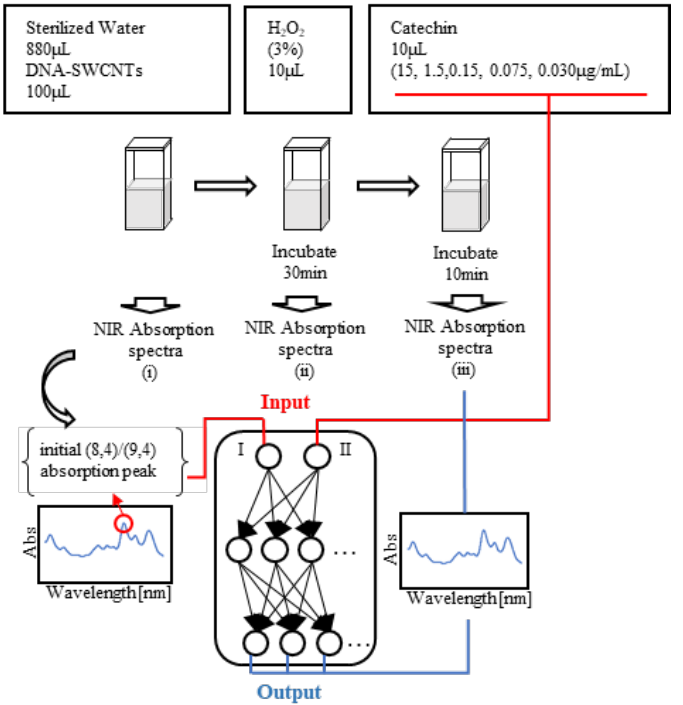
Figure 2. Overview of the learned BRBPNN model. Initial (8,4)/(9,4) peak absorption and catechin concentration are used as input data I, II, and NIR spectra after catechin addition in (iii) state as output data.